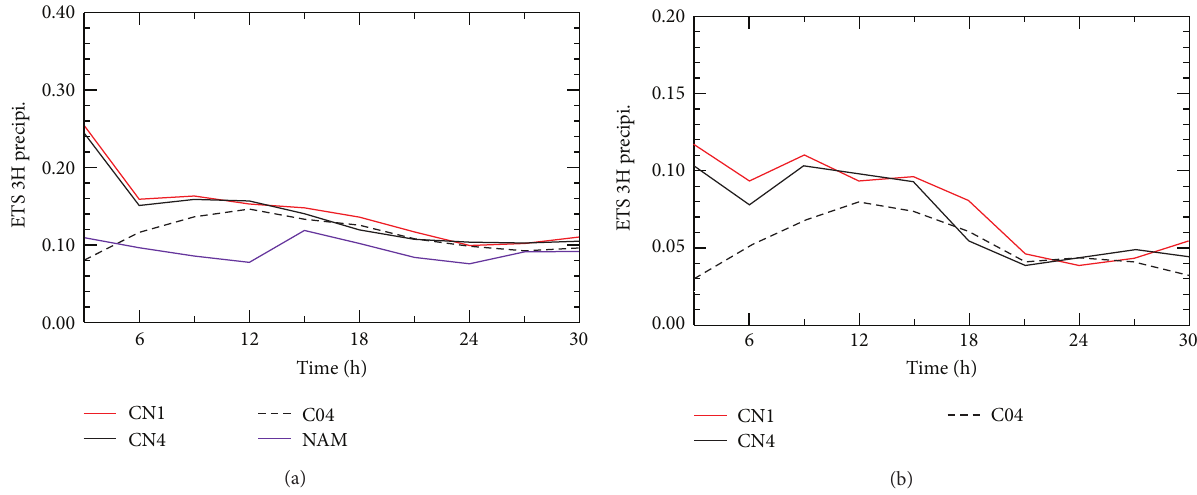
Figure 5: Mean equitable threat scores (ETSs) of 3-hour accumulated precipitation at 0.1 inch (a) and 0.5 inch (b) thresholds, for the 1km forecast with radar data (CN1, solid red), 4km control (CN4, solid black), and 4km run without radar data (C04, dashed black), for forecasts of 23 days from the CAPS 2009 spring forecast